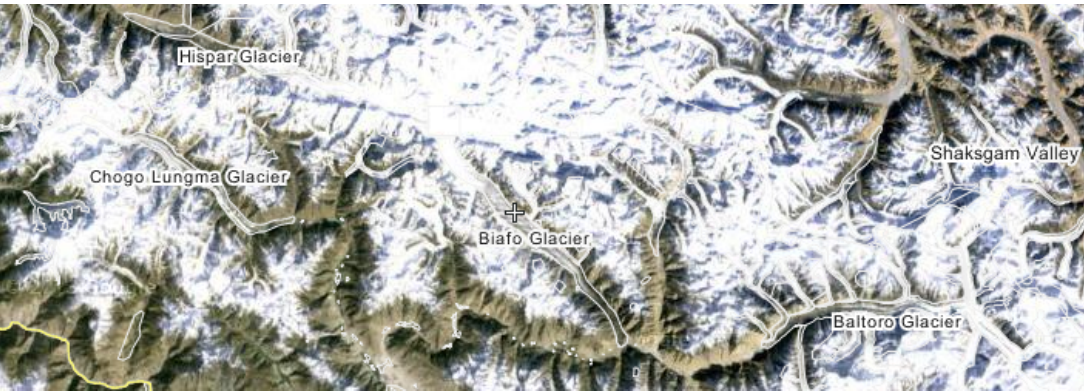
Figure 2: Karakoram, Kashmir region, North Pakistan